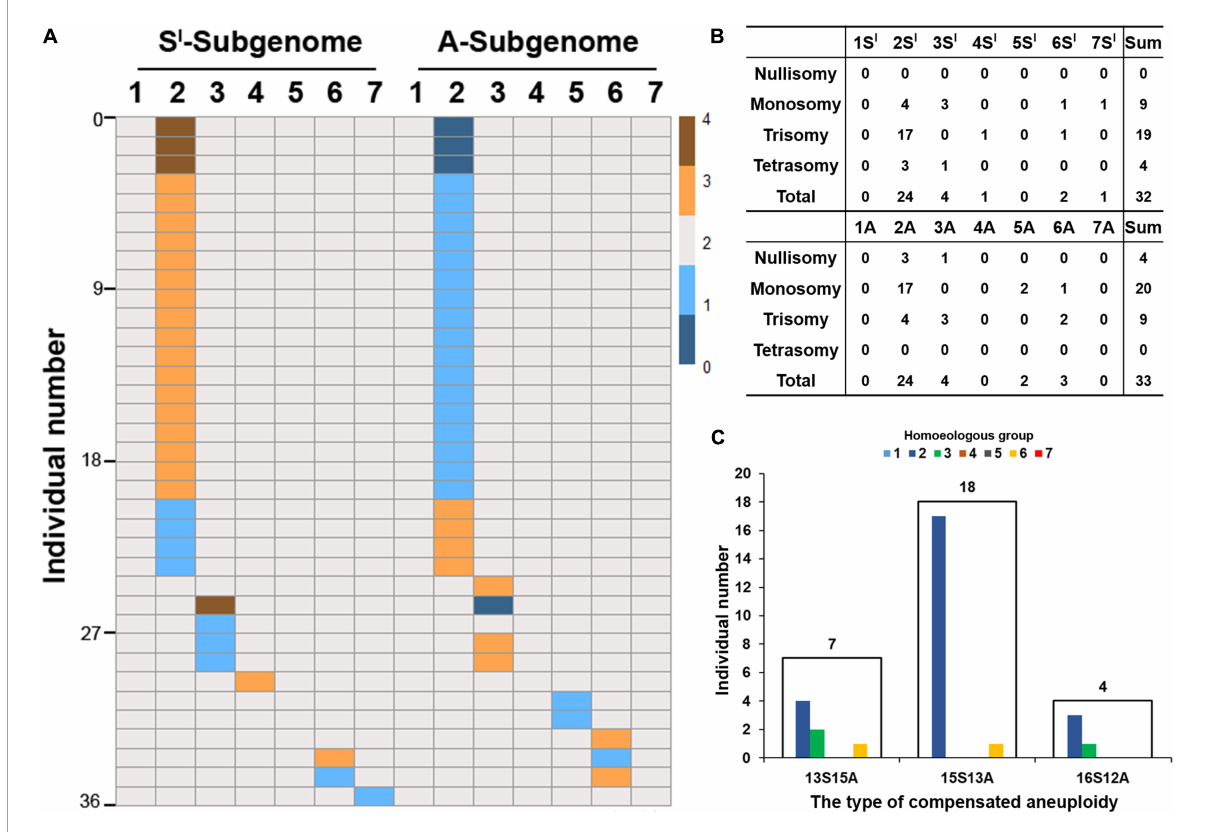
FIGURE3 Numerical chromosome variations (NCVs) in the 526 karyotyped individuals. The heatmap (A) shows gain or loss of chromosomes among the 14 chromosome pairs of subgenomes S l and A, which occurred in 36 of the 526 individuals. Color key represents chromosome copies from 0 to 4. (B) Is distribution of the numbers of individuals showing variable copies (from 0 to 4) of each of the 14 pairs of chromosomes. (C) Depicts the numbers of plants in the three different types of compensated aneuploidies. The digits above the frames are numbers of individuals belonging to each of the three types of compensated aneuploidies. The colored bars are individual numbers belonging to each of the seven homoeologous groups within each of the three types of compensated